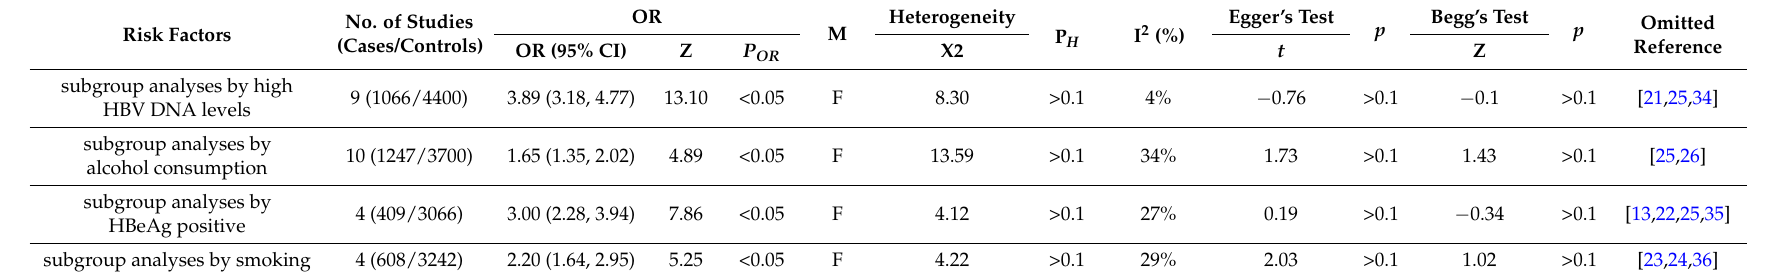
Table 3. The adjusted subgroup characteristics of possible risk factors associated with HCC in HBsAg-positive Chinese